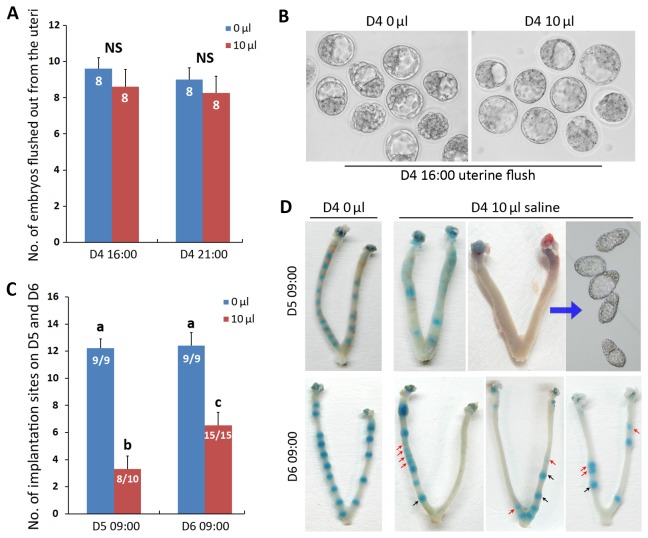
Cause of decreased implantation sites were not due to “flush out” of embryos, but due to abnormal “on time” and “on site” implantation.(A) The intrauterine embryo numbers were comparable between 10 μl and 0 μl fluid infused groups at different time points (NS: P > 0.05). (B) Demonstrative pictures of blastocysts flushed out at Day4 16:00 showed similar morphology between 10 μl and 0 μl fluid infused groups. (C) Number of implantation sites examined on Day5 and Day6 revealed delayed timing of implantation after 10 μl fluid infusion, groups with different superscript letters (a, b, c) are significantly different from each other (P < 0.01). Numbers within bars mean No. of mice with implantation sites/No. of mice examined. (D) Representative photos of normal and abnormal implantation sites examined on Day5 and Day6. Uteri without blue band were further processed for uterine flushing to examine whether blastocysts were existed. Note that embryo spacing was also disrupted especially on Day6. The black arrow showed relatively normal implantation sites, the red arrow showed delayed or abnormally spaced implantation sites.